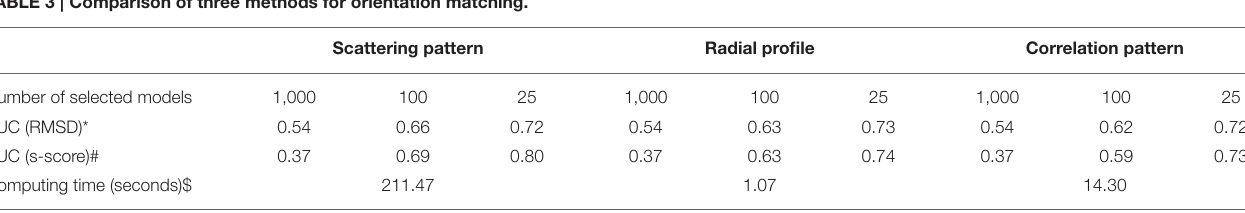
TABLE 3 | Comparison of three methods for orientation